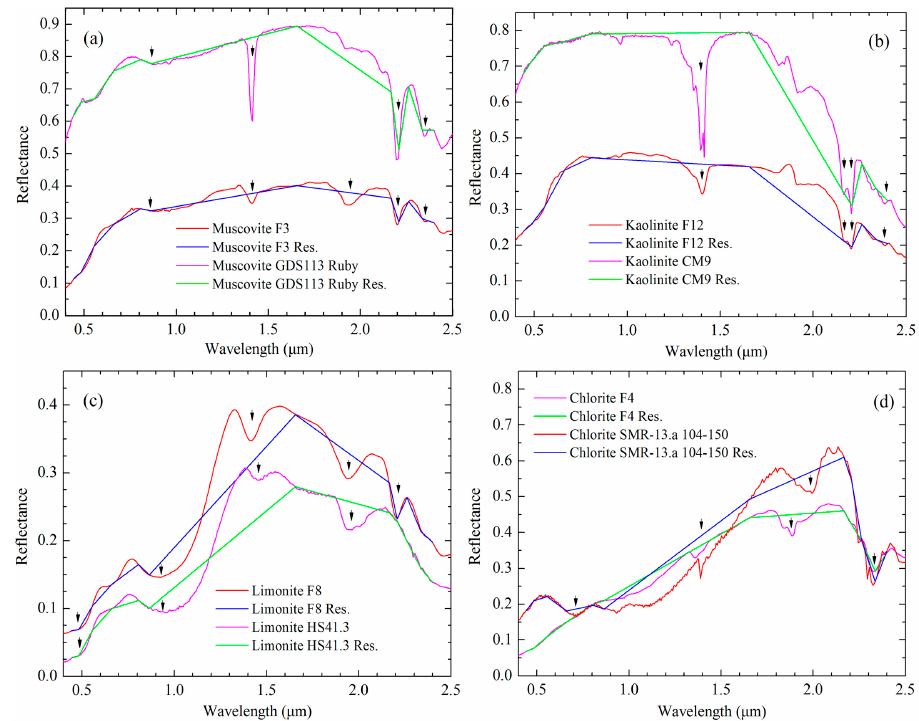
Figure 5. Laboratory and field samples of mineral reflectance spectra in study area. The spectra of Res. are resampled to AO bandpasses. ( a ) F3: field sample number 3; Muscovite GDS 113 Ruby coming from USGS-SL; ( b ) F12: field sample number 12; Kaolinite CM9 coming from USGS-SL; ( c ) F8: field sample number 8; Limonite HS41.3 coming from USGS-SL; ( d ) F4: field sample number 4; Chlorite SMR-13.a coming from USGS-SL.